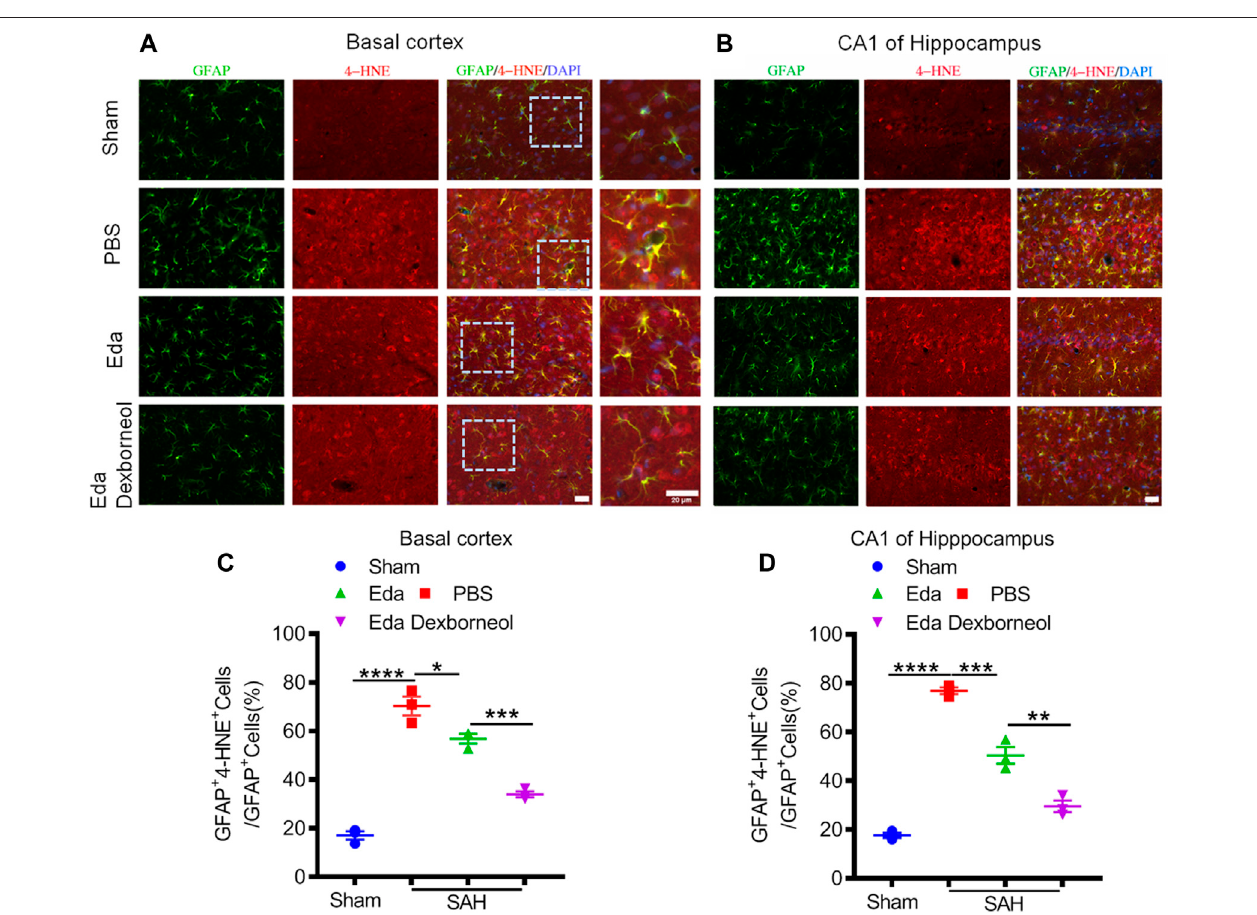
FIGURE7| Edaravonedexborneol treatmentdecreasesthelevelsof4-HNEinastrocytesafterSAHinjury. (A,B) Representativeimmuno fl uorescenceimagesof4- HNE (red)/GFAP (green)-stained astrocytesin the basalcortex (A) and CA1 ofthe hippocampus (B) at 3 d after SAH. Scale bar:20 µm. (C,D) Quantitative analysisof4- HNE+astrocytesinthebasalcortex (C) andCA1ofthehippocampus (D) at3 dafterSAH. n =3/group.Dataaregivenasmean±SE.* p < 0.05,** p < 0.01,*** p < 0.001, **** p < 0.0001. Eda: edaravone; Eda dexborneol: edaravone dexborneol.